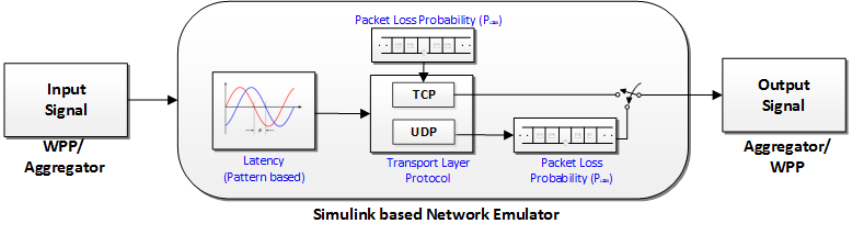
Figure 7. CNM used for evaluation of Online Frequency Support from WPPs.